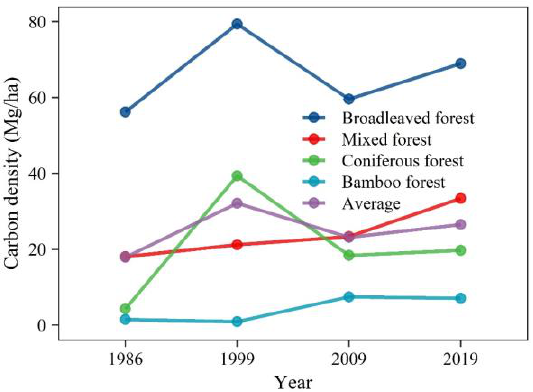
Figure 5. Vegetation carbon density changes in different forest types from 1986 to 2019.